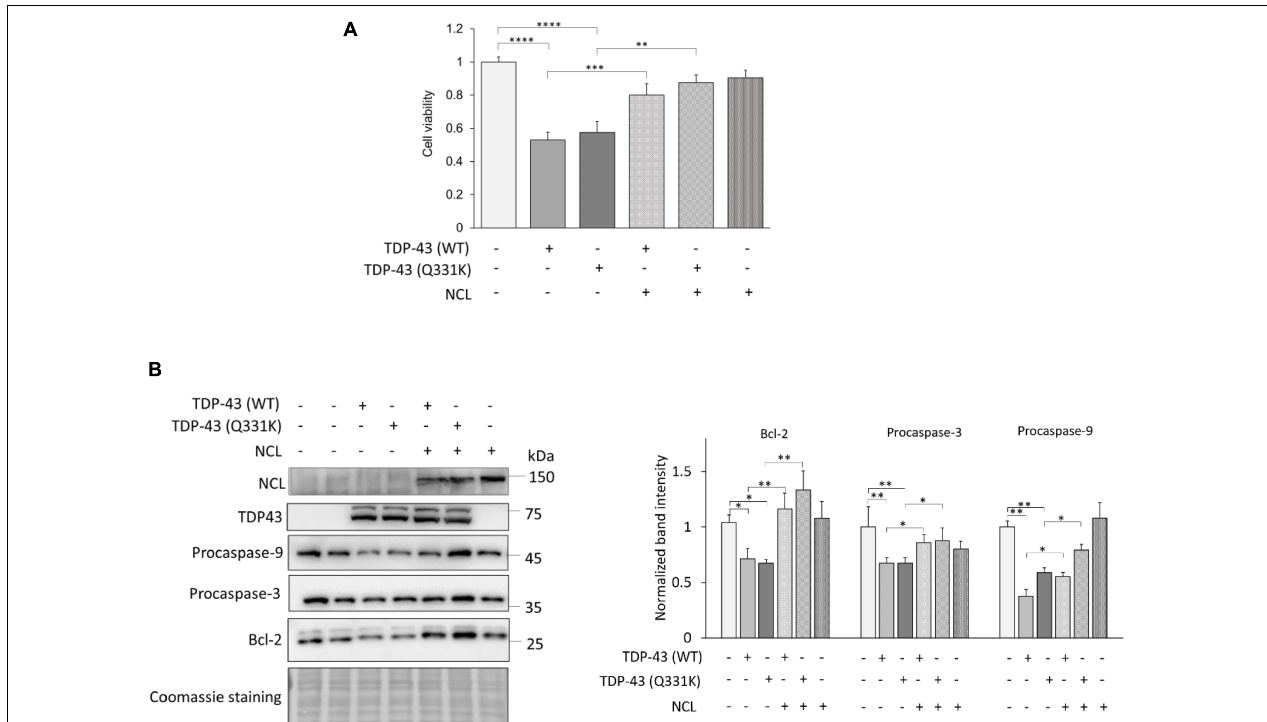
FIGURE 8 | NCL rescues apoptosis induced by TDP-43 overexpression in human HEK293T cells. (A) Cell viability of HEK293T cells transiently expressing TDP-43-mKate2 [either WT or bearing the Q331K missense mutation, TDP-43 (WT) and TDP-43 (Q331K), respectively] and NCL-GFP (NCL) (+). As controls (–), cells were co-transfected with plasmids encoding mKate2 and/or GFP only. Data were normalized to the mean value of control samples (–/–/–). n = 15; ∗∗ p < 0.01, ∗∗∗ p < 0.001, ∗∗∗∗ p < 0.0001, Kruskal–Wallis test followed by a Dunn’s post hoc test. (B) WB analysis of lysates of HEK293T cells co-transfected as in (A) using antibodies to GFP (recognizing the NCL-GFP chimera), TDP-43, the anti-apoptotic factor Bcl-2, and procaspase-3 and -9. The left panel shows a representative WB out of four biological replicates (i.e., different cell transfections) also showing the Coomassie blue staining of the membrane; the right panel reports the